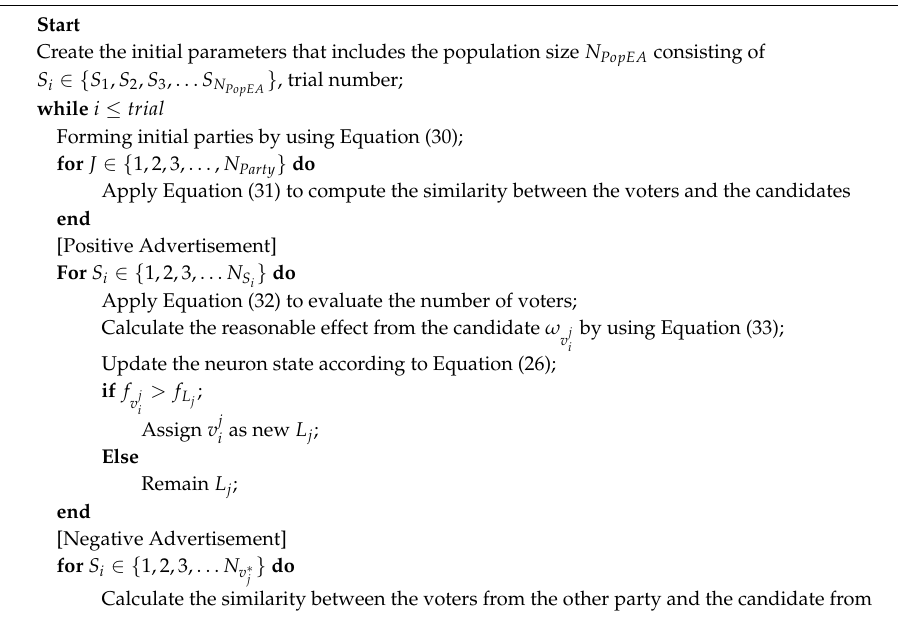
Algorithm 3: The pseudocode of EA in the training